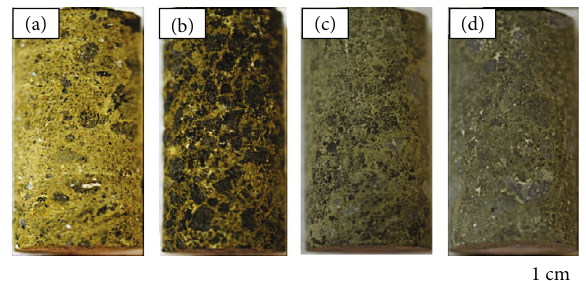
Figure 1: Photographs of representative sample cores of hyaloclastite from di ff erent depths within the hydrothermal reservoir at Kra fl a volcano, NE Iceland. (a) The surface hyaloclastite is matrix supported, containing dark, glassy basaltic scoria clasts. (b) The subsurface 70m hyaloclastite sample contains a higher volume of prominent dark scoria clasts. (c) The subsurface hyaloclastite from 556m is matrix supported and contains some scoria clasts which appear compacted, and overall, the material appears denser. (d) The subsurface 732m hyaloclastite sample contains matrix-supported light grey basaltic